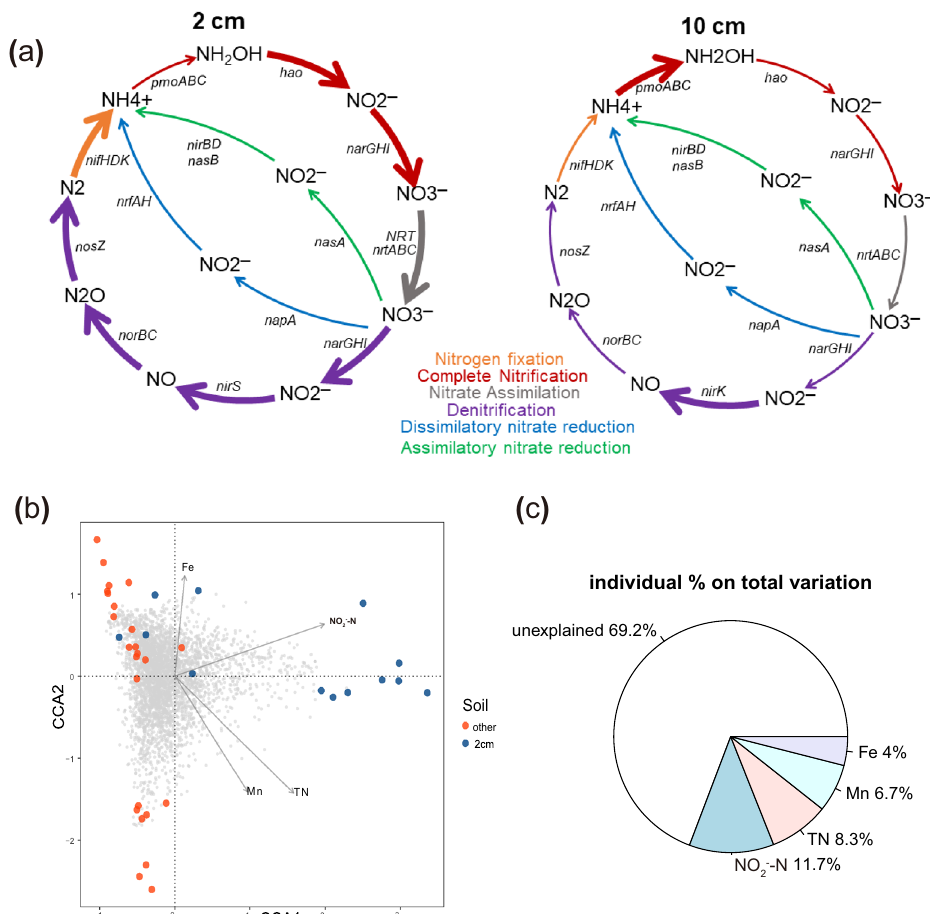
Fig. 7 Correlation between environmental factors and microbial community and potential functions of microbiomes. Schematic diagram of nitrogen metabolism ( a ), canonical correlation analysis (CCA) of the microbial community ( b ), and variation partition of different variables ( c ) on microbial community dissimilarity of soil 2cm/10cm distance from metal